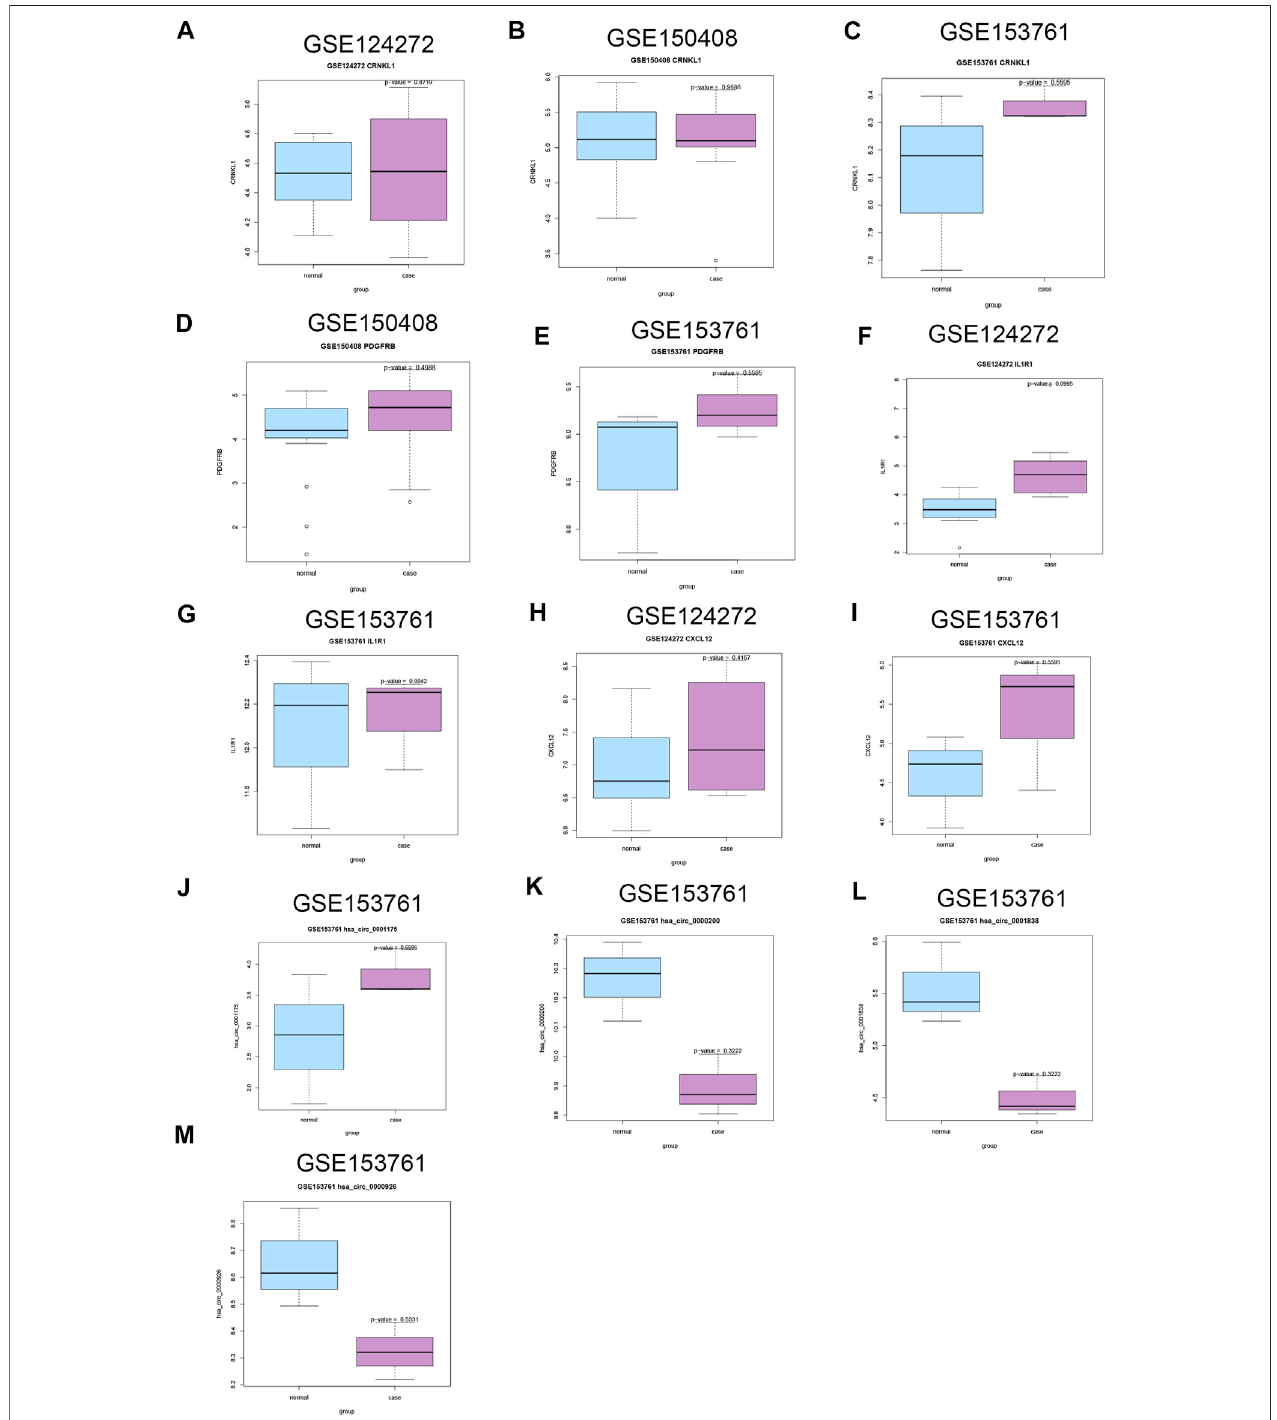
FIGURE 8 | Validation of the expression of candidate DECs, DEMis, and DEMs in external GEO microarray datasets related to IDD. The difference of CRNKL1 expression between IDD and HC in GSE124272 (A) , GSE150408 (B) , and GSE153761 (C) ; the difference of PDGFRB expression between IDD and HC in GSE150408 (D) andGSE153761 (E) ;thedifferenceofIL1R1expressionbetweenIDDandHCinGSE124272 (F) andGSE153761 (G) ;thedifferenceofCXCL12expressionbetween IDD and HC in GSE124272 (H) and GSE153761 (I) ; the difference of hsa_circ_0001175 expression between IDD and HC in GSE153761 (J) ; the difference of hsa_circ_0000200 expression between IDD and HC in GSE153761 (K) ; the difference of hsa_circ_0001838 expression between IDD and HC in GSE153761 (L) ; the difference of hsa_circ_0000926 expression between IDD and HC in GSE153761 (M) . DEC: differentially expressed circular RNAs; DEMis: differentially expressed microRNAs: DEMs: differentially expressed mRNAs; IDD: intervertebral disc degeneration; and GEO: Gene Expression Omnibus.